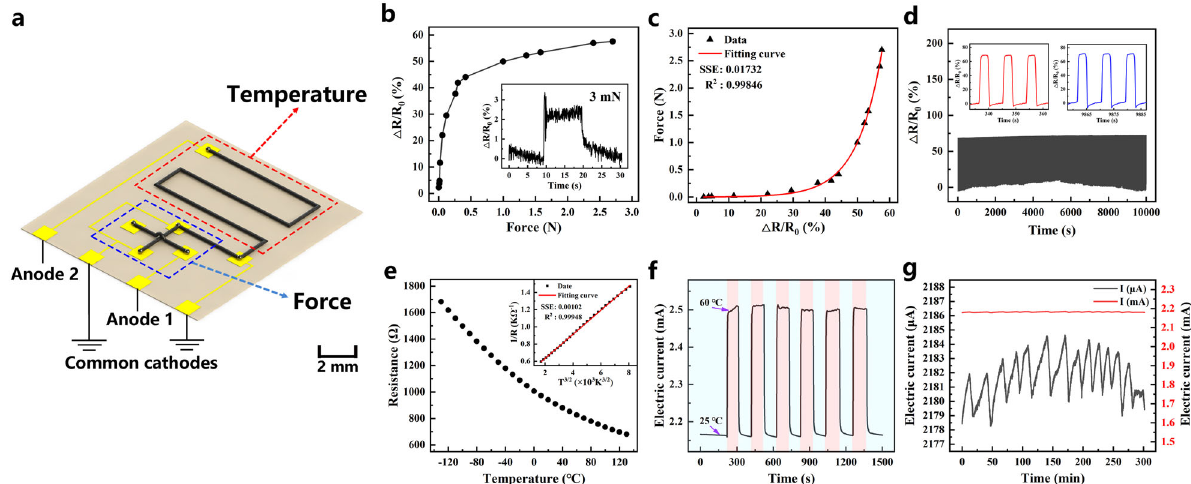
Fig. 1 Flexible sensor integrated with temperature and force sensing properties. a Schematic diagram for the fl exible sensor. b Relationship of the resistance change rate with the applied force. Inset: the response curve for the minimum force at 3 mN. c Data- fi tting curve for the force sensing. d A cycling test comprising 1000 cycles under the overload force at 20 N. Inset: the response curves before and after one thousand cycles. e Temperature response curve for the fl exible sensor. Inset: data- fi tting curve satisfying the relationship of the impurity scattering mechanism. f Temperature response curves recorded by our fl exible sensor during a six heating – cooling cycle test. g Five hours temperature stability test at room temperature of 25